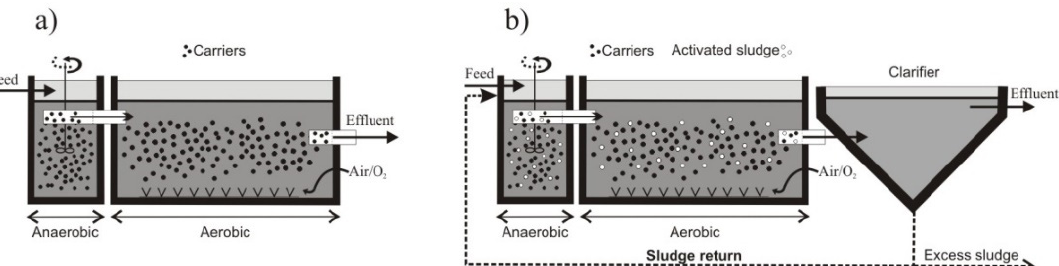
Figure 1. Schematic comparison of moving bed biofilm bioreactor (MBBR) ( a ) and integrated fixed- film activated sludge (IFAS) ( b ).